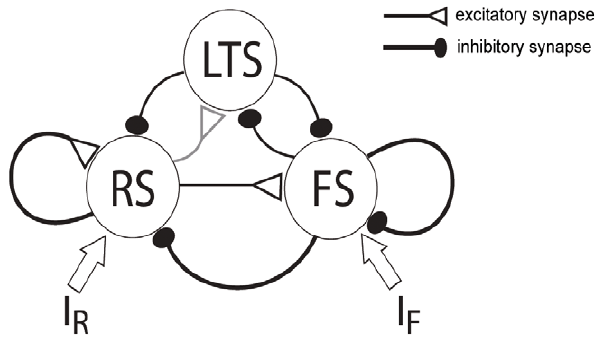
Figure 1. Schematic architecture of the RS-LTS-FS cortical circuit. Open triangles denote excitatory synapses, and solid ellipses denote inhibitory synapses. Black lines denote depressing synapses, and grey lines denote facilitating synapses.